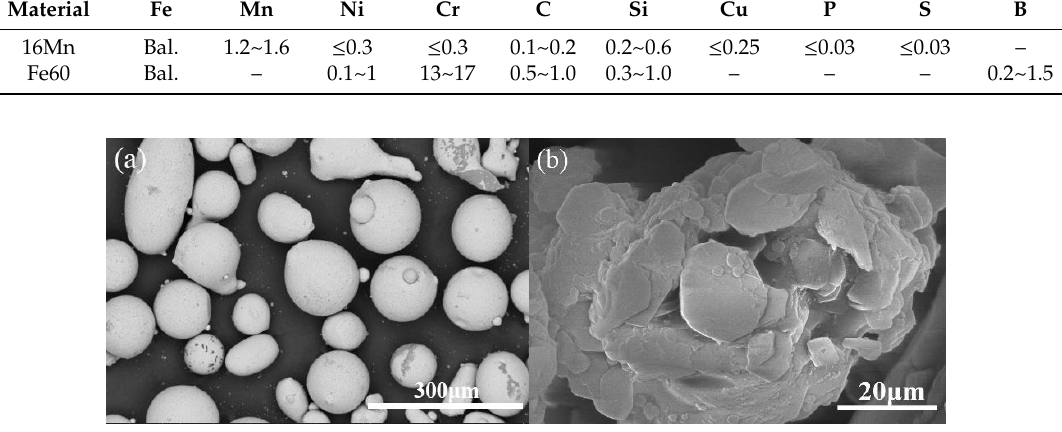
Figure 1. The morphologies of experimental powders: ( a ) Fe60 alloy powder; ( b ) Ti 3 SiC 2 particles.